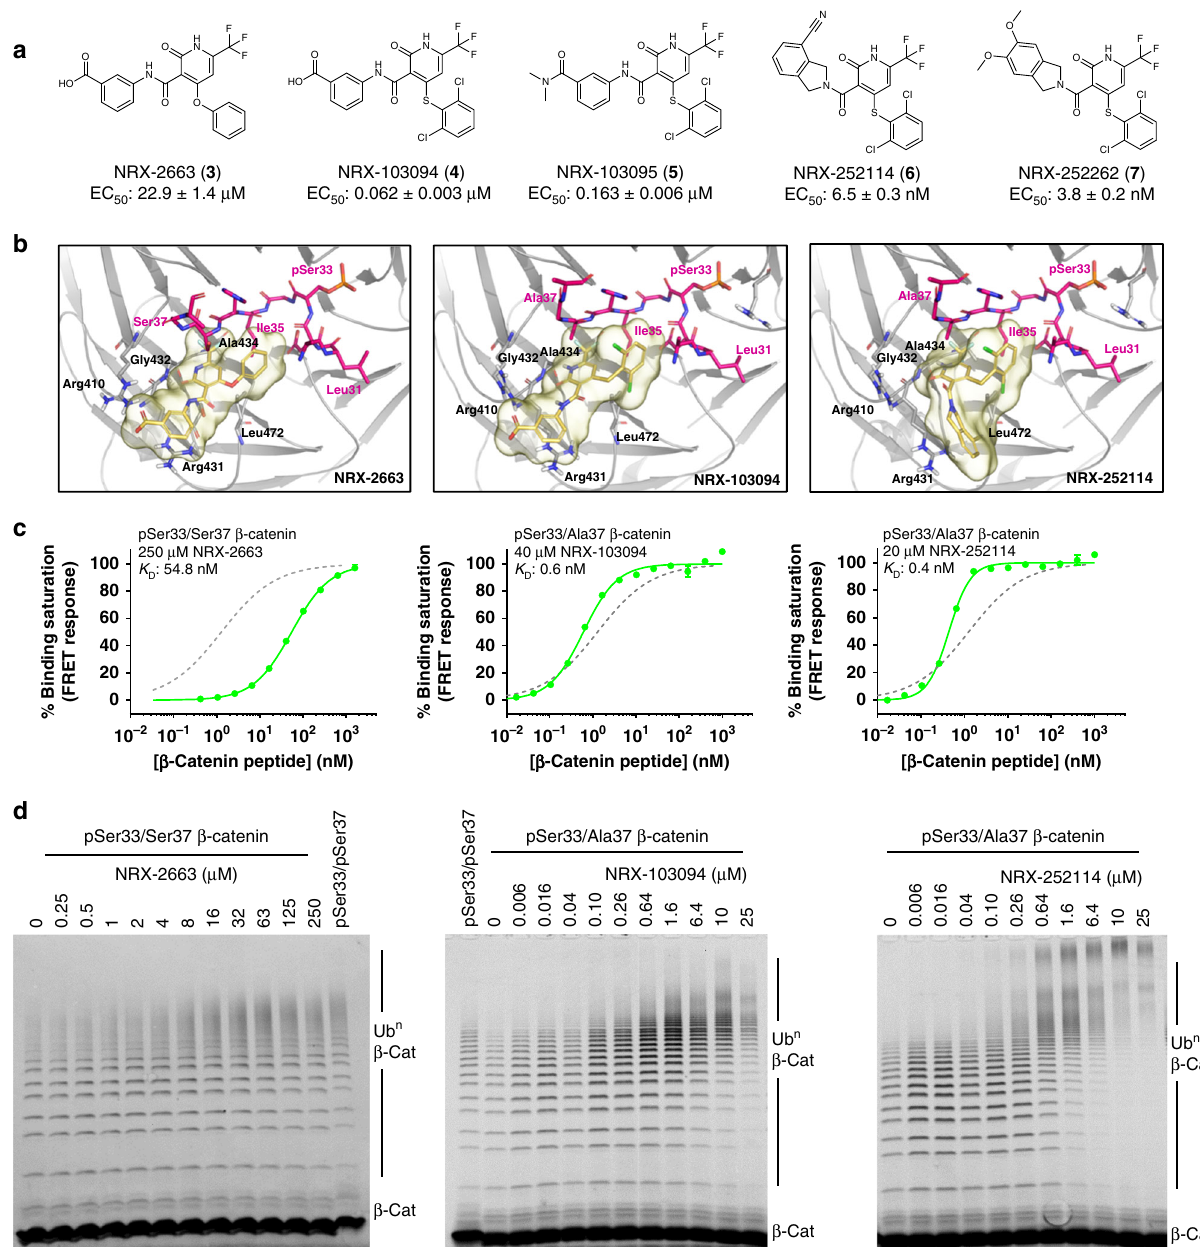
Fig. 3 Optimized enhancers potentiate pSer33/S37A β -catenin binding and ubiquitylation. a Chemical structure of optimized enhancers and their potency in TR-FRET assay against pSer33/S37A β -catenin peptide for β -TrCP binding. b Structures of enhancers (yellow) in complex with β -catenin peptide (magenta) and β -TrCP (gray). The binding poses and β -catenin degron conformations shown for NRX-2663 (PDB: 6M92) and NRX-103094 (6M91) are from crystal structures (Supplementary Table 1), whereas the NRX-252114 pose was determined by computational docking. c Binding af fi nities of the β - catenin peptides (as indicated) for β -TrCP were measured in the TR-FRET assay in presence of enhancers at concentration indicated. For NRX-252114, the binding assay is bottoming out due to 300 pM β -TrCP concentration, with the curve fi t yielding a higher than expected hill slope of 1.8. Therefore, the K D reported for NRX-252114 represents an upper estimate. For reference, the binding curve for pSer33/pSer37 β -catenin peptide in the same TR-FRET assay is represented in dotted gray line with a K D of 2 nM. d 4 μ M of fl uorescently-labeled β -catenin peptide (residues 17 – 60; as indicated) was ubiquitylated in the by SDS-PAGE and imaged for fl uorescence